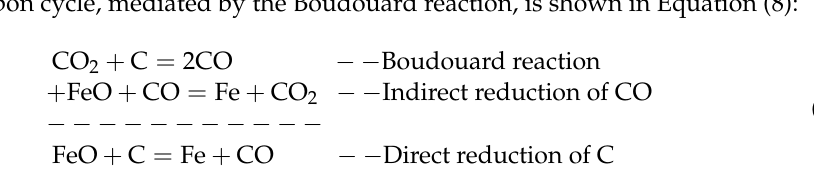
Table 4. The composition of the reduction thermodynamic system.